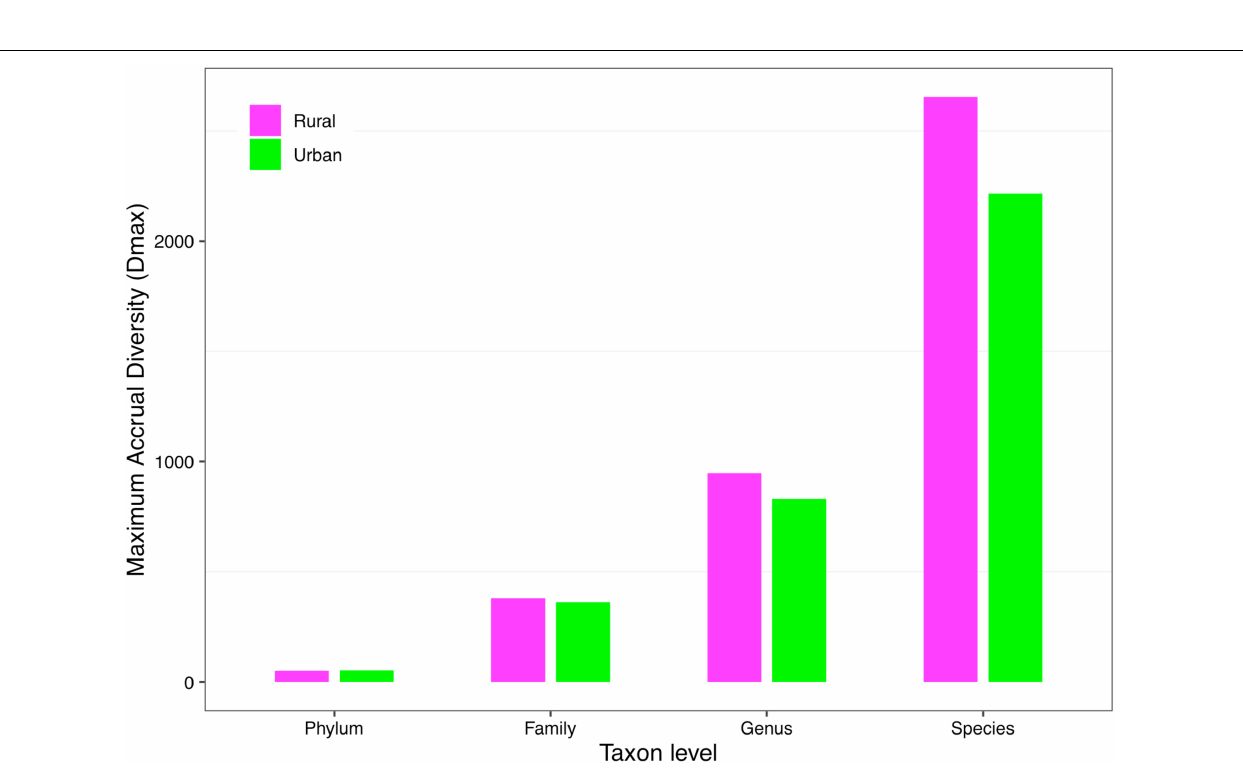
Frontiers in Microbiology |